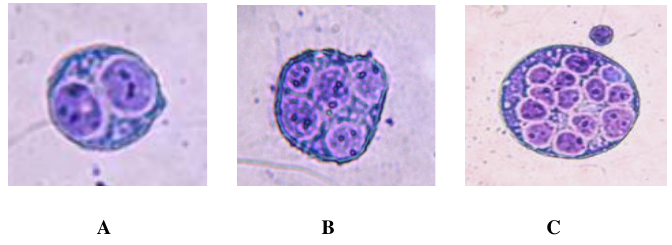
FIGURE 2 . Heterogeneity of syncytia generated in vitro by the fusion of Env + and CD4 + Jurkat cells in 5-h cocultures. (A) Binucleated cell; (B) five-nuclei cell; (C) multinucleated cell. Cells were stained with Giemsa.